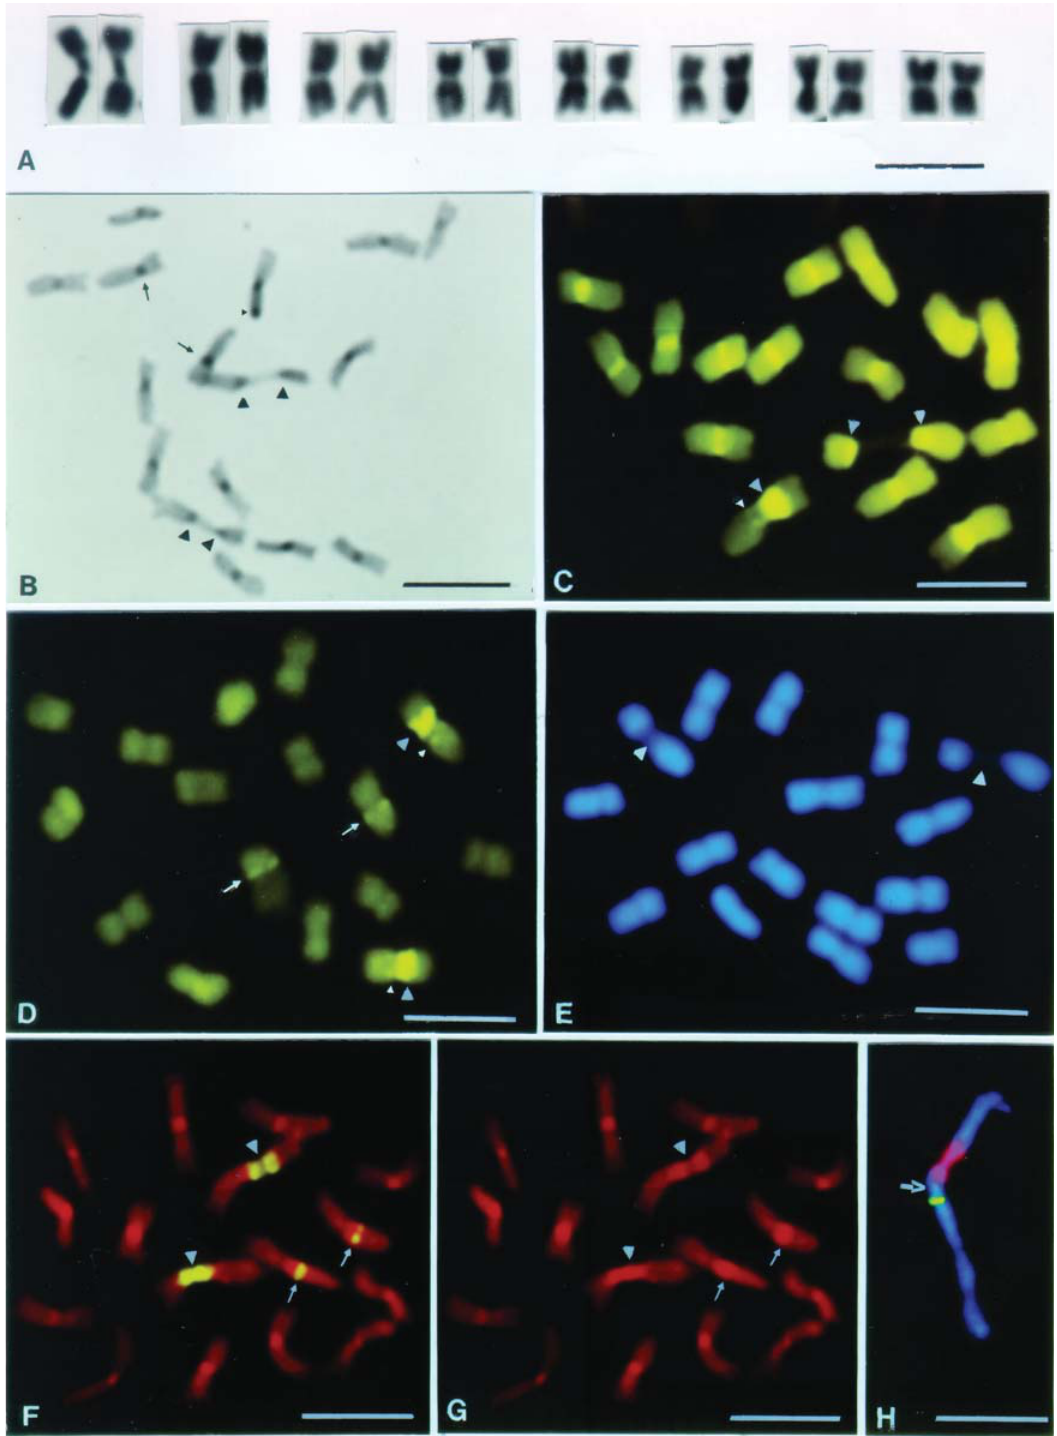
Figure 1 - Mitotic metaphase chromosomes of Crotalaria juncea (A-G). Arrowheads and small arrows indicate chromosomes 1 and 4, respectively (B-G). KaryotypeshowingFeulgen-stainedchromosomes(A).C-bandedchromosomesshowingpericentromericbandsandheterochromaticblocksadjacenttothe secondaryconstrictionontheshortarmofchromosome1;notetheC-bandonthelongarmofchromosome4;smallarrowheadindicatesasignal(ortechnical artifact) that was not consistently observed in other cells (B) CMA staining showing GC-rich heterochromatic regions; note a tiny band on the long arm of one of the chromosome 1 homologues (small arrowhead) (C). CMA/DA-stained chromosomes with fluorescence quenching at pericentromeric hetero- chromaticblocksandbrightbandsonthelongarmofchromosomes1(smallarrowhead)and4,andNOR-heterochromatin(D).DAPI-stainedchromosomes showing negative fluorescence in the NOR region of chromosome 1; (E). FISH with 45S rDNA probes detected with FITC. (F). Counterstaining with propidiumiodideshowingtheC-bandingpattern;notetheheterochromaticblocksofchromosomes1and4(G).Chromosome1atmitoticprophaseshowing signals of FISH with probes of 45S rDNA detected with TRITC, and 5S rDNA (FITC); the arrow indicates the centromere